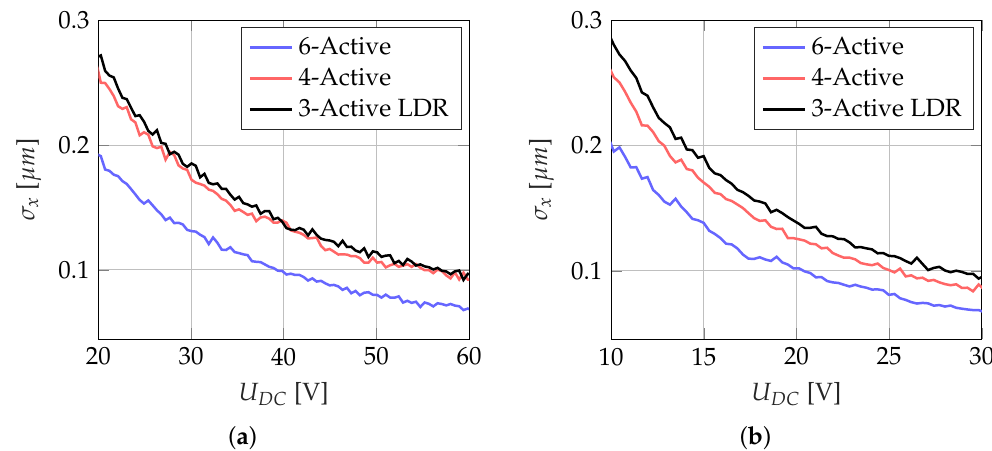
Figure 17. ( a ) Noise comparison of the self-sensing position measurement. ( b ) Reduction of the noise at low levels of U DC by an adaption of the analog circuit ( f PWM = 20 kHz, rotor fixed in the center of the bearing, standard deviation σ x over 3000 samples of the x-position at each setpoint of U DC ).